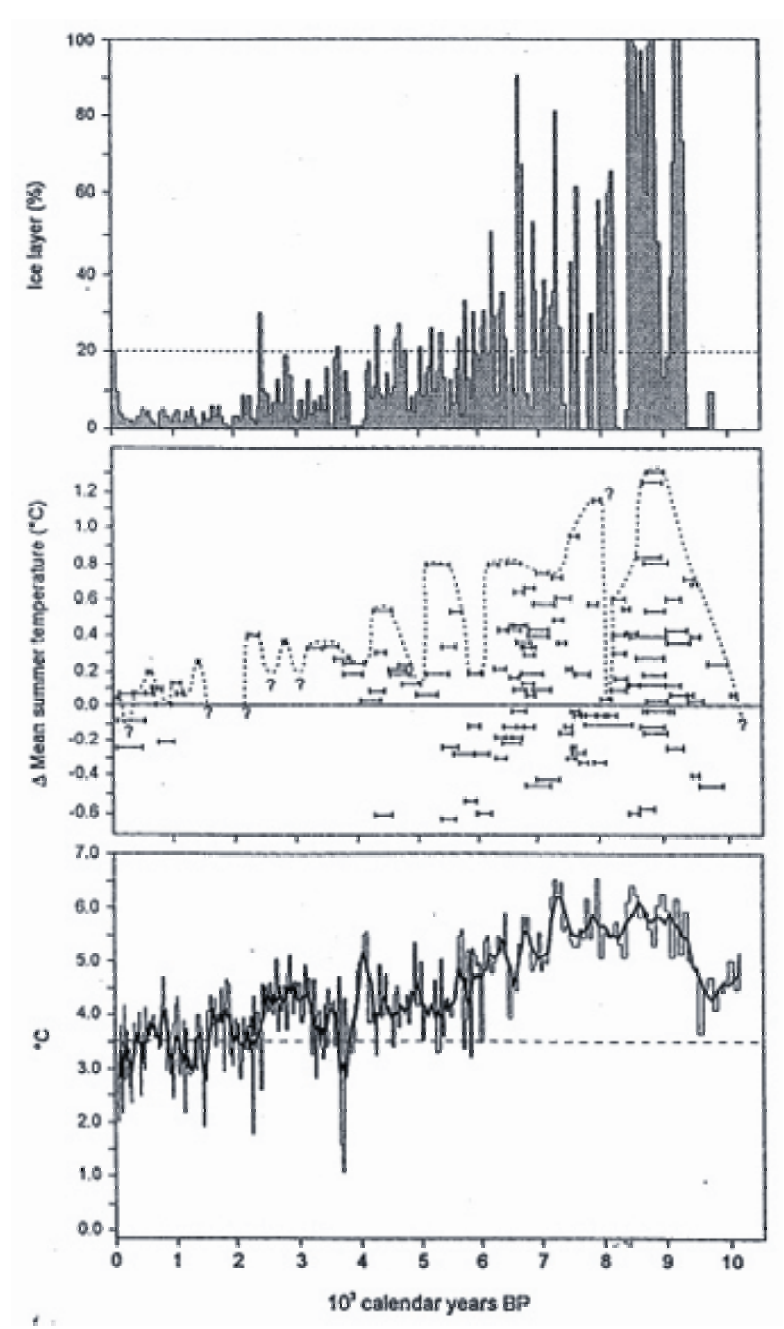
FIGURE 8. Temperature indicators during the present interglacial (Holocene) from (a) ice melt in core from Ellsmere Is., (b) elevation of tree line (Sweden), and (c) oxygen isotope temperature proxy from stalagmites